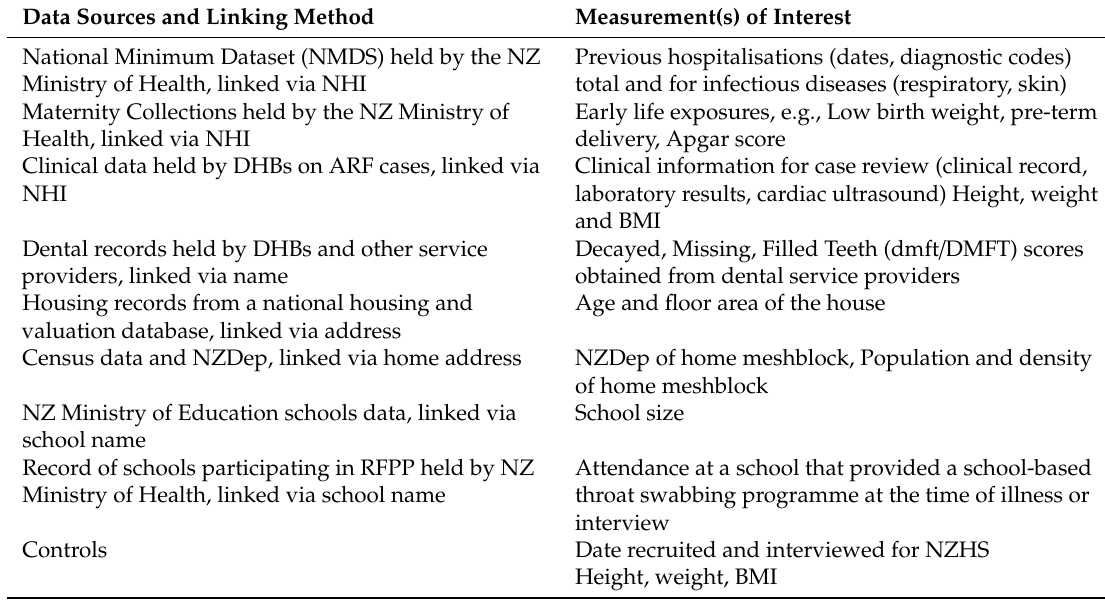
Table 4. Linked data sources and associated measurements and records of